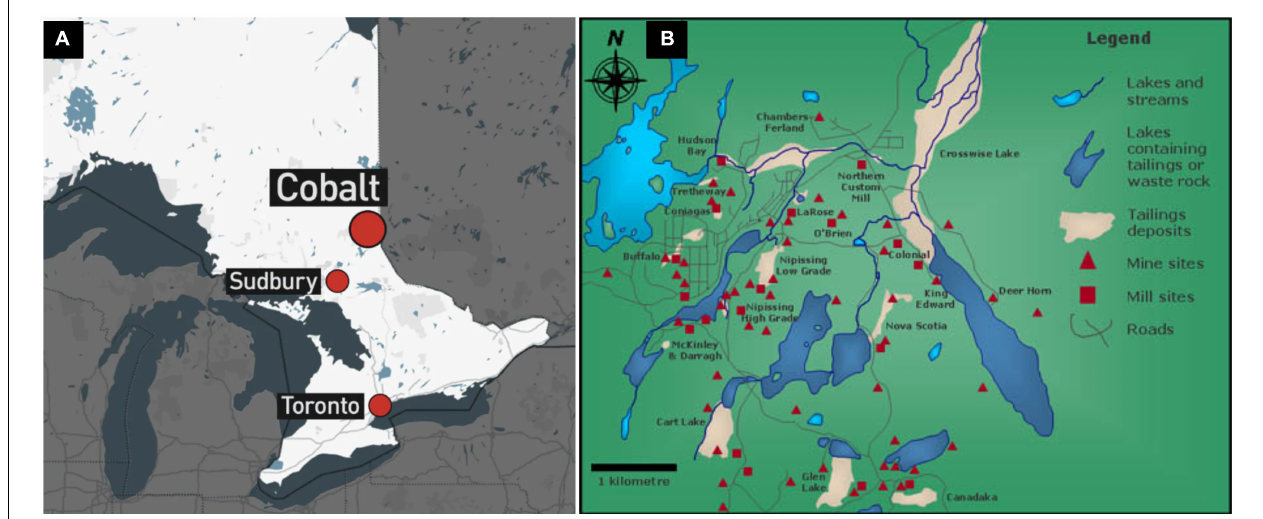
FIGURE 1 | Maps indicating (A) the location of Cobalt in Ontario, relative to Sudbury and Toronto and (B) the mines, mills, and tailings deposits in the Cobalt Mining Camp.